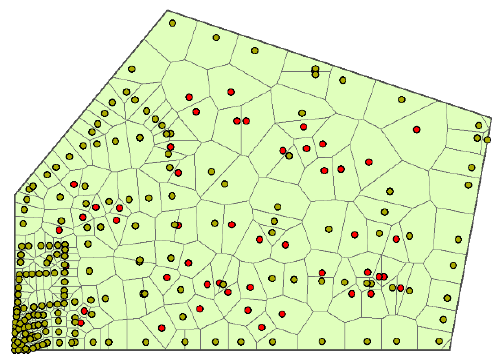
Figure 2. Nodes within a Voronoi diagram of the overland flows and drainage pipe network.